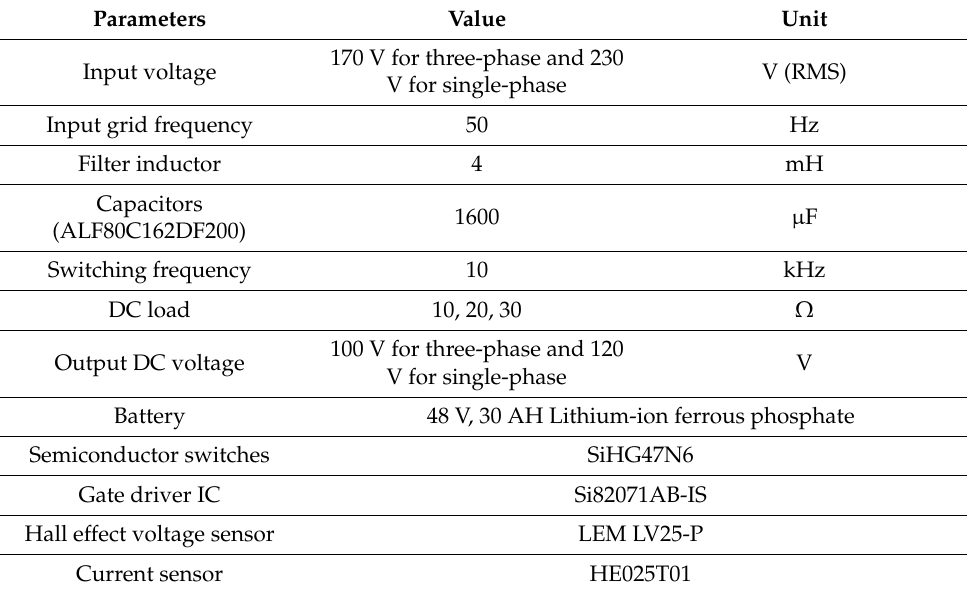
Figure 11. Photograph of the laboratory setup for validation of the proposed three-phase rectifier. Table 5. Parameters for experimental verification of the proposed multilevel rectifier.